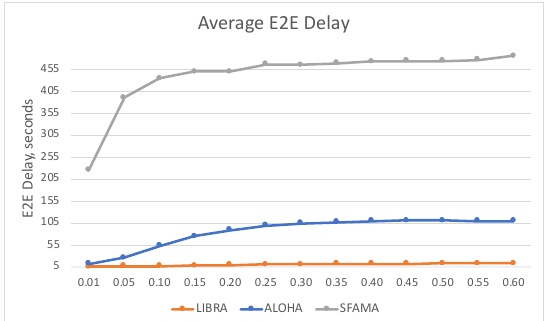
Figure 12. Average end-to-end delay, in